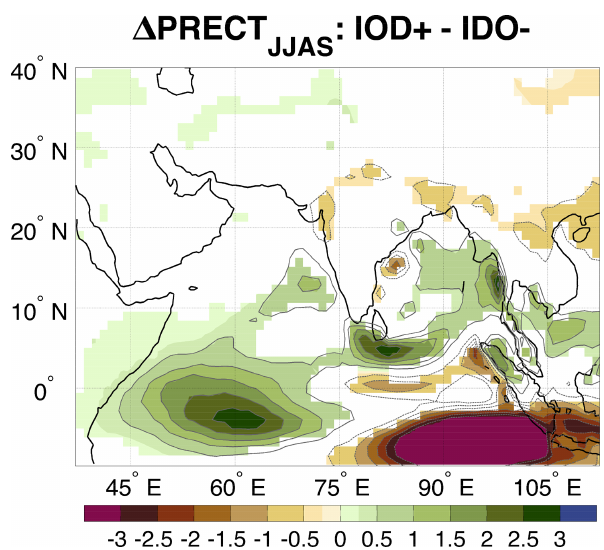
Figure A5. Difference between the positive and negative phases of the Indian Ocean dipole (IOD) composite for summer (JJAS) precipitation (PRECT, mm/d) in the PI experiment. Only differences significant at the 95% confidence level using the Student t test are shaded. The contours follow the color-bar intervals (solid for positive and dashed for negative anomalies; the zero line is omitted).